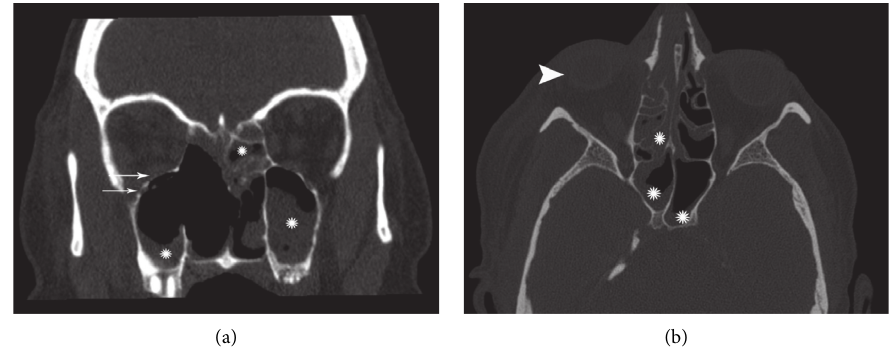
Figure 1: (a) Destruction of orbital bone (white arrows) and sinus involvement (white asterisk). Destruction of the nasal septum is also seen. (b) Proptosis secondary to eye involvement by mucor (white arrowhead) and sinus involvement (white asterisk).